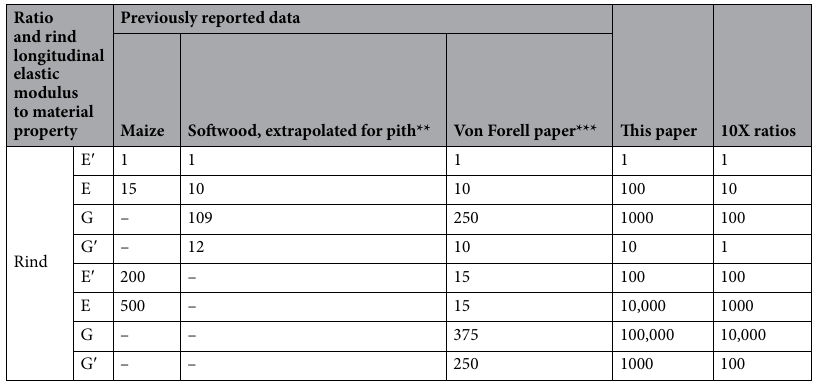
Table 1. Mechanical properties ratios of maize stalk tissues reported/used in previous experimental and modeling studies. Since some maize properties have never been reported in the literature, typical mechanical properties of softwood species are also provided as a point of reference. Note that all properties are reported as ratios of the Young’s Modulus of the rind (top row). Ratios are also shown for an order of magnitude change between E ′ , E, G ′ , and G, shown in the rightmost column. * 14,16 , **, *** 5